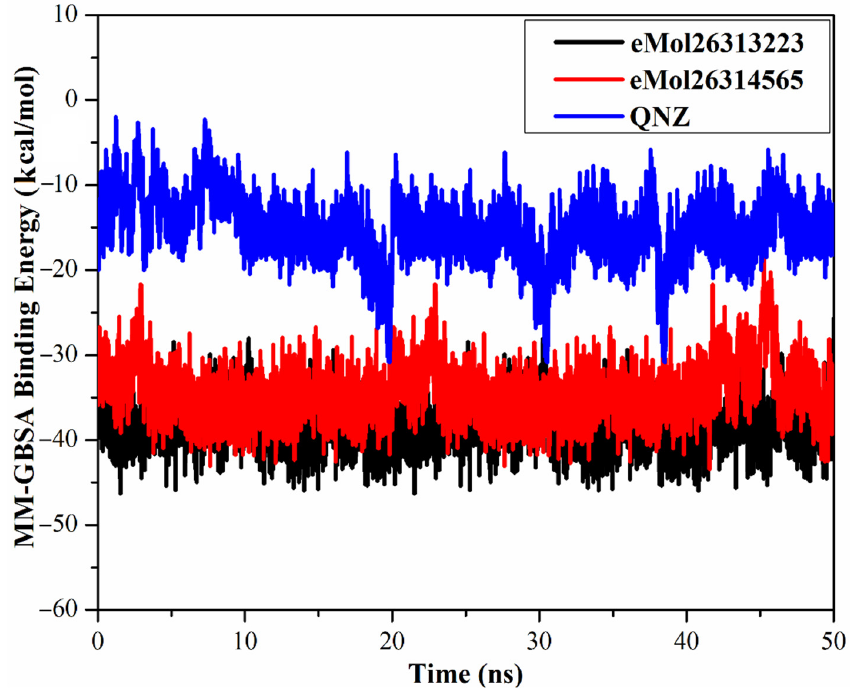
Figure 6. Estimated MM-GBSA binding energy per frame for eMol26313223 (in black), eMol26314565 (in red), and QNZ (in blue) with mutated PBP2a allosteric site in acidic medium throughout the 50 ns MD simulations.